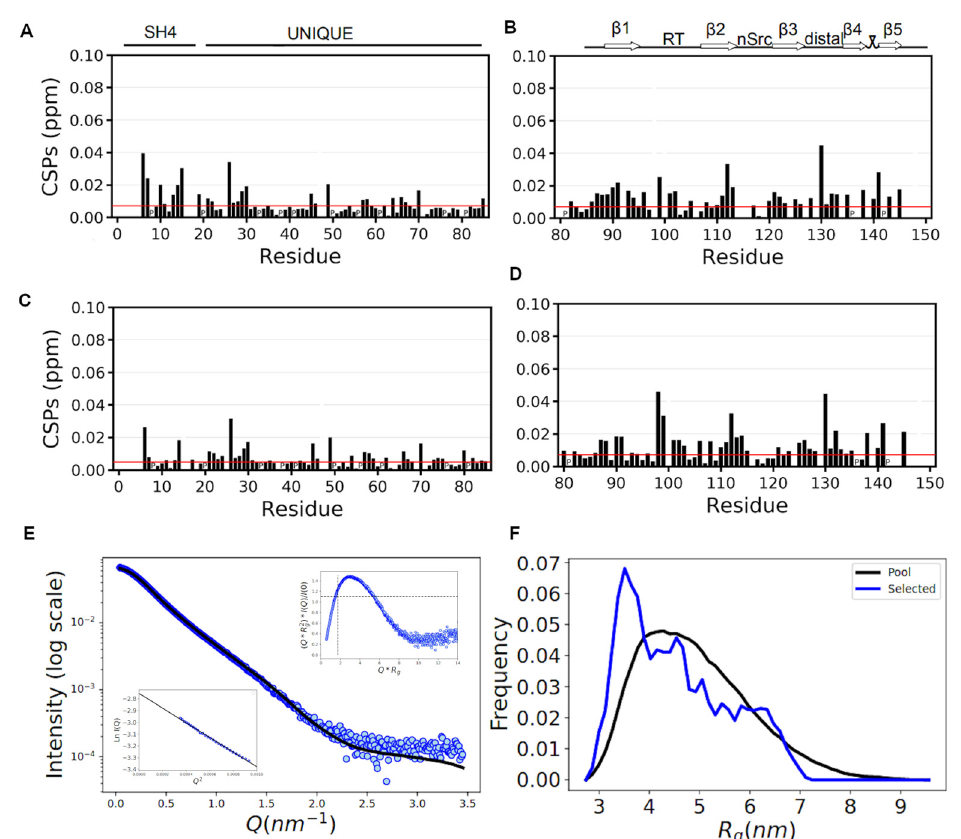
Figure 2. NMR chemical shift perturbation of CLOBY ( A , B ) and TEV-treated CLOBY ( C , D ) with respect to the isolated SNRE region of Src without the fluorescent proteins. Chemical shift differences were measured at 278 K for the disordered regions ( A , C ) and at 298 K for the SH3 domains ( B , D ). Red lines represent five standard deviations from the mean of the lowest 10% CSD. SAXS data of CLOBY are presented in panel ( E ). The main figure is the intensity profile, while the inserts represent a normalized Kratky plot (upper right) and a Guinier plot (lower left). Panel ( F ) presents the R g distribution of the EOM-selected subensembles that best reproduce experimental SAXS data (blue) compared with the R g distribution of the initial pool (in black).